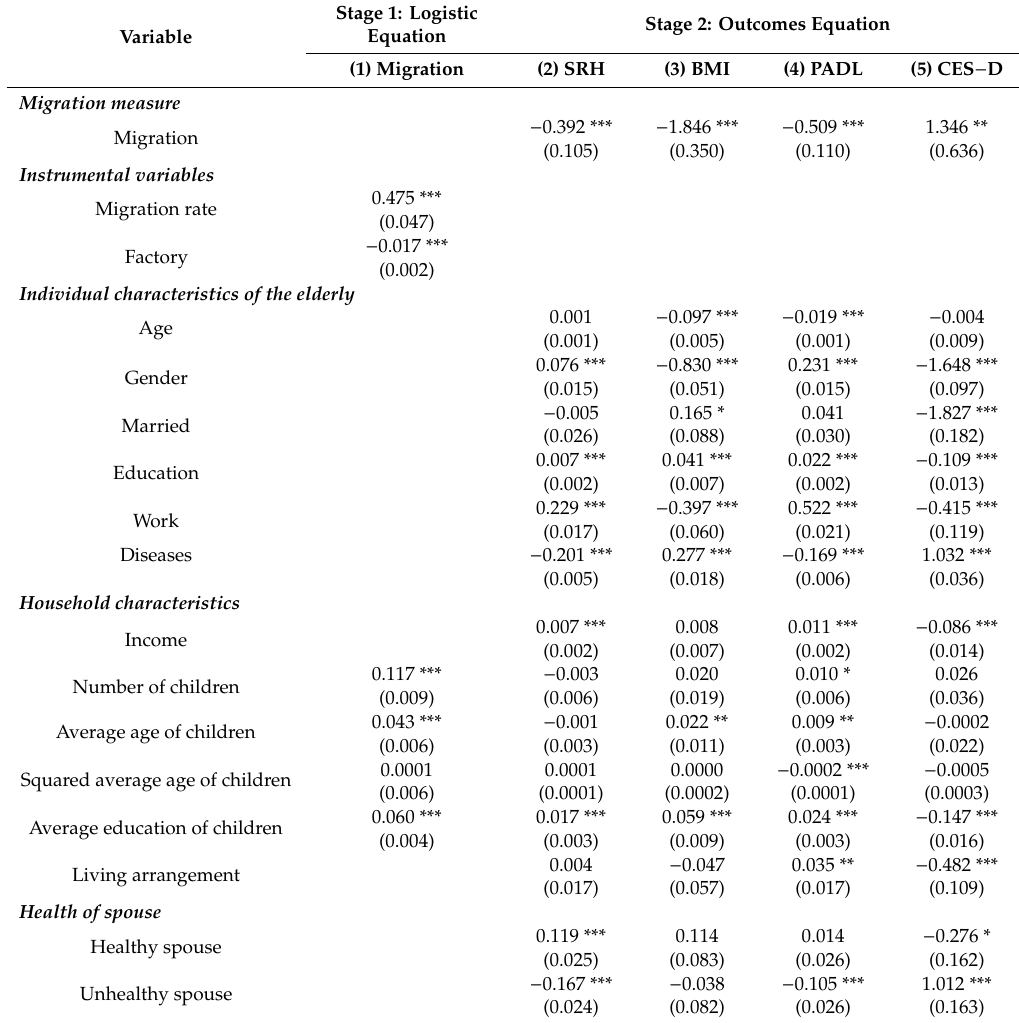
Table 2. Baseline model of child migration and parental